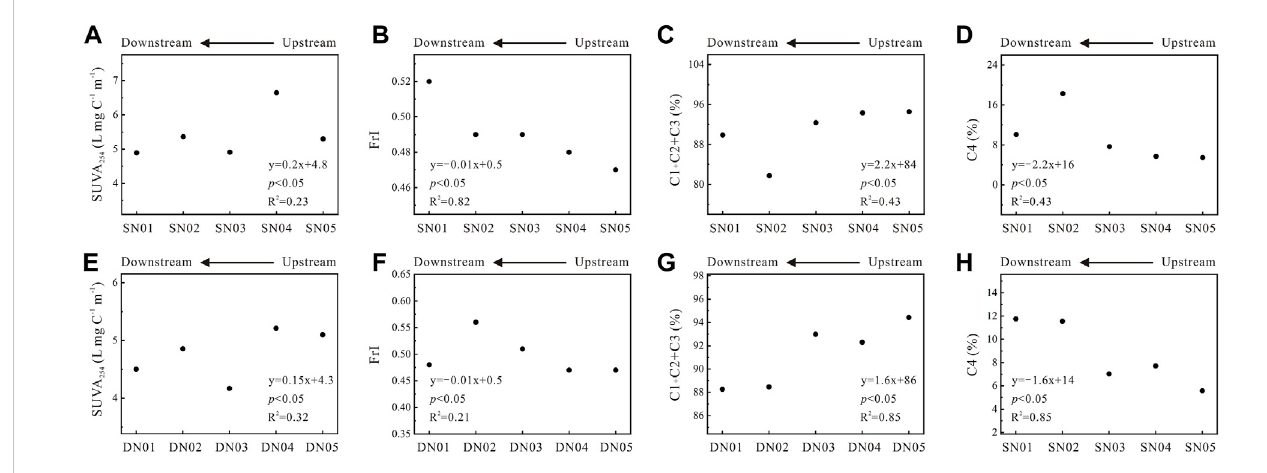
FIGURE 3 Optical properties of water-extractable organic matter (WEOM) in SNR and DNR. (A) SUVA 254 , (B) FrI, (C) C1+C2+C3, and (D) C4 in SNR; (E) SUVA 254 , (F) FrI, (G) C1+C2+C3, and (H) C4 in DNR. Note: SUVA 254 , speci fi c ultraviolet absorbance at 254 nm; FrI, freshness index; C1, Component 1; C2, Component 2; C3, Component 3; C4, Component 4.